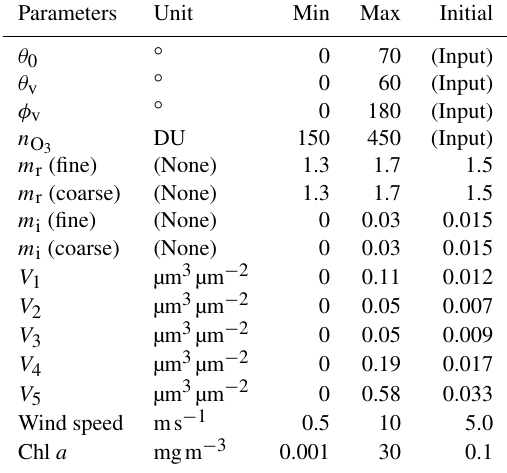
Table 2. Parameters used to represent the atmosphere and ocean system for the radiative transfer simulation and NN training. θ 0 and θ v are the solar and viewing zenith angles. φ v is the relative view- ing azimuth angle. V i denotes the five volume densities defined in Eq. (8). m r and m i are the real and imaginary parts of the refractive index. Ozone column density ( n O ) in the atmosphere, ocean sur- 3 face wind speed, and Chl a are also provided. The minimum ( min ) and maximum (max) values determine the parameter ranges used to generate NN training data, which are also the constraints in the re- trieval algorithm. The initial values are the ones used in the retrieval optimization algorithm, where θ 0 , θ v , φ v , and n O are assumed to 3 be known from